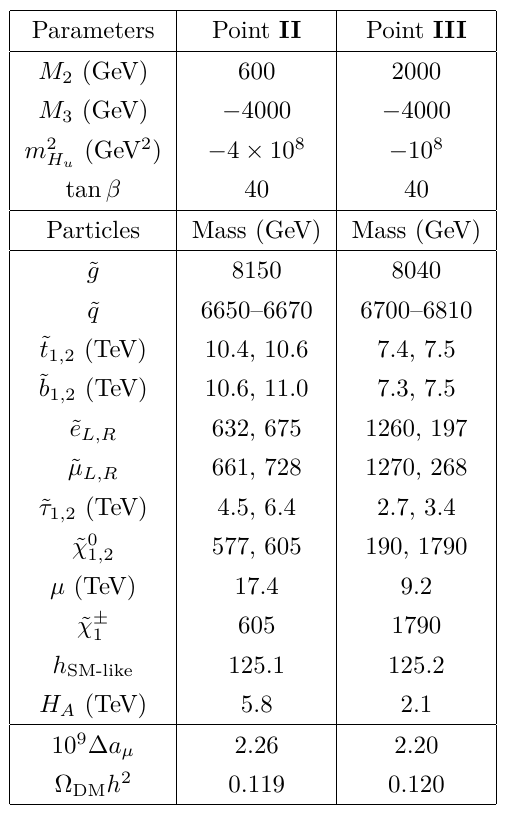
Table 2 . Mass spectra in the model B and C . We take M N